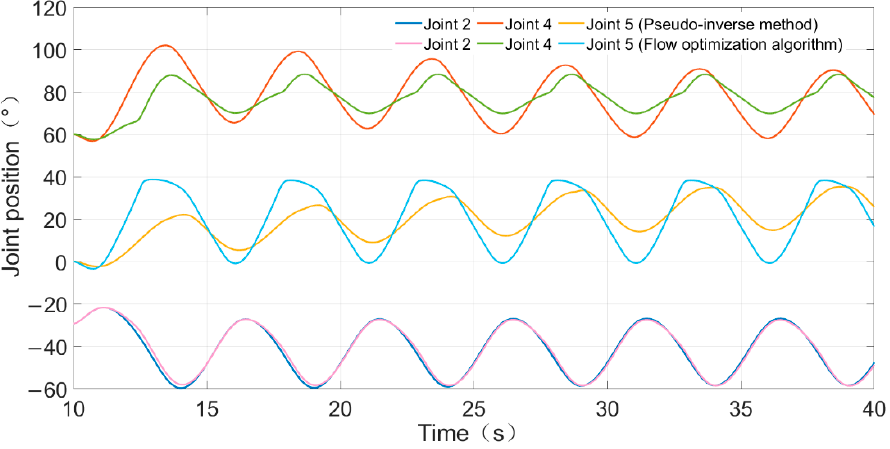
Figure 7. Flow optimization algorithm experiment—the comparison diagram of joint position.